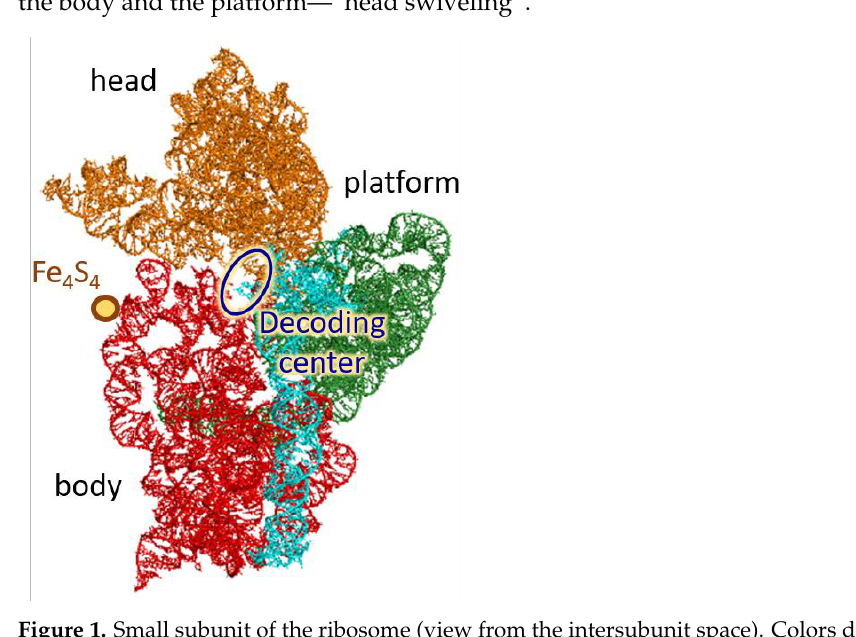
Figure 1. Small subunit of the ribosome (view from the intersubunit space). Colors depict four SSU domains: 5′ domain (red), central (green), 3′ major (orange), and 3′ minor (cyan).